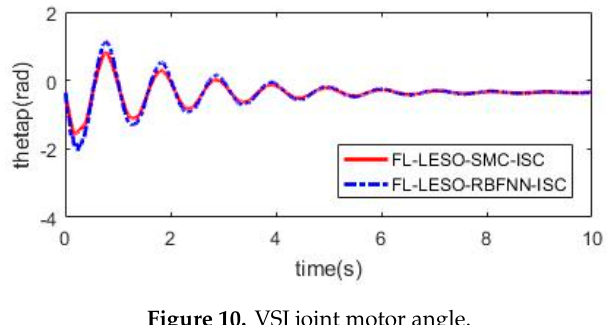
Figure 10. VSJ joint motor angle.